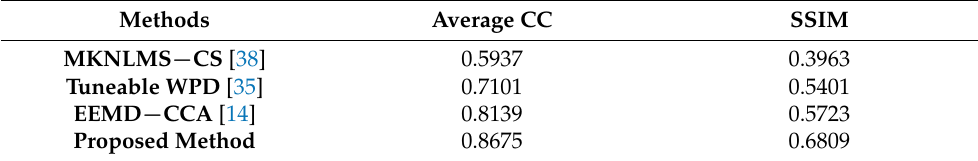
Table 8. Performance comparison on simulated